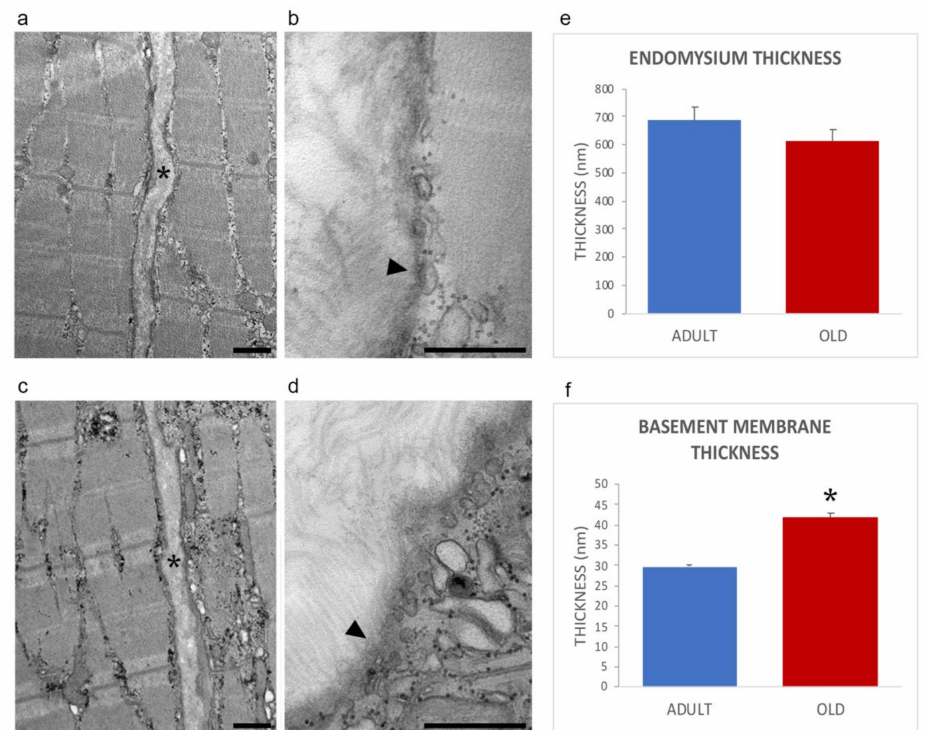
Figure 2. Ultrastructural images of the endomysium in adult ( a , b ) and old ( c , d ) gastrocnemius muscle. *, endomysium; arrowhead, basement membrane. Bars: 500 nm. The endomysium and basement membrane thickness are reported in panels ( e ) and ( f ), respectively. * p < 0.001.